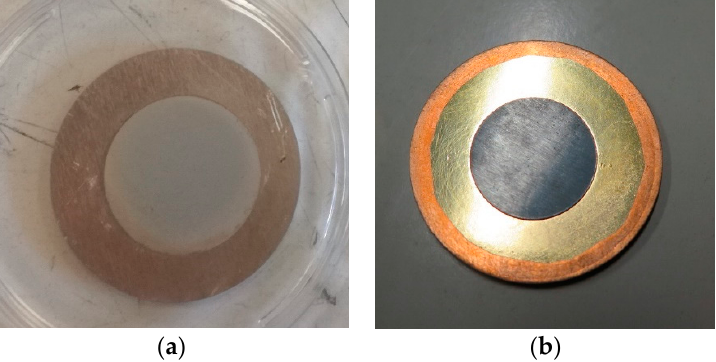
Figure 10. Mo targets prepared with high energy vibrational powders plating (HIVIPP) method starting from reduced powders ( a ) and spark plasma sintering (SPS)-sintered target from 100 Mo of Isoflex ( b ).